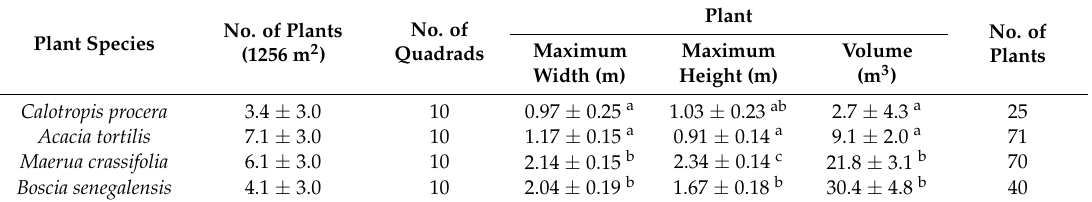
Table 1. Mean ( ± SE) number of plants per circular quadrat (40 m diameter, n = 10) and plant size of four species frequently roosted on at the survey